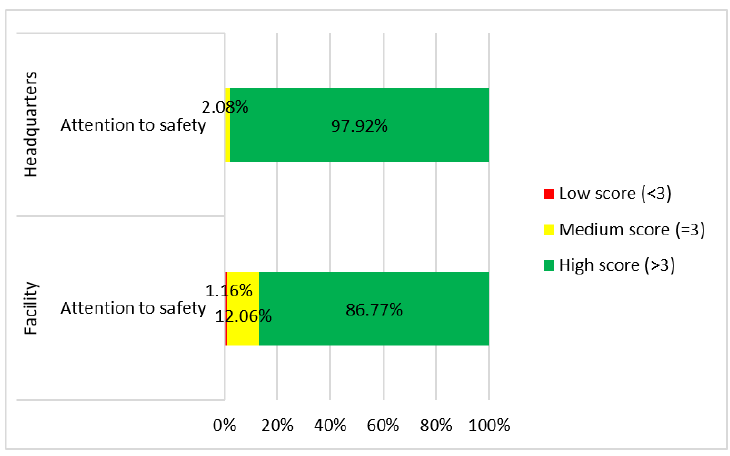
Figure 11. Categorized BARS percentages for attention to safety, by location.